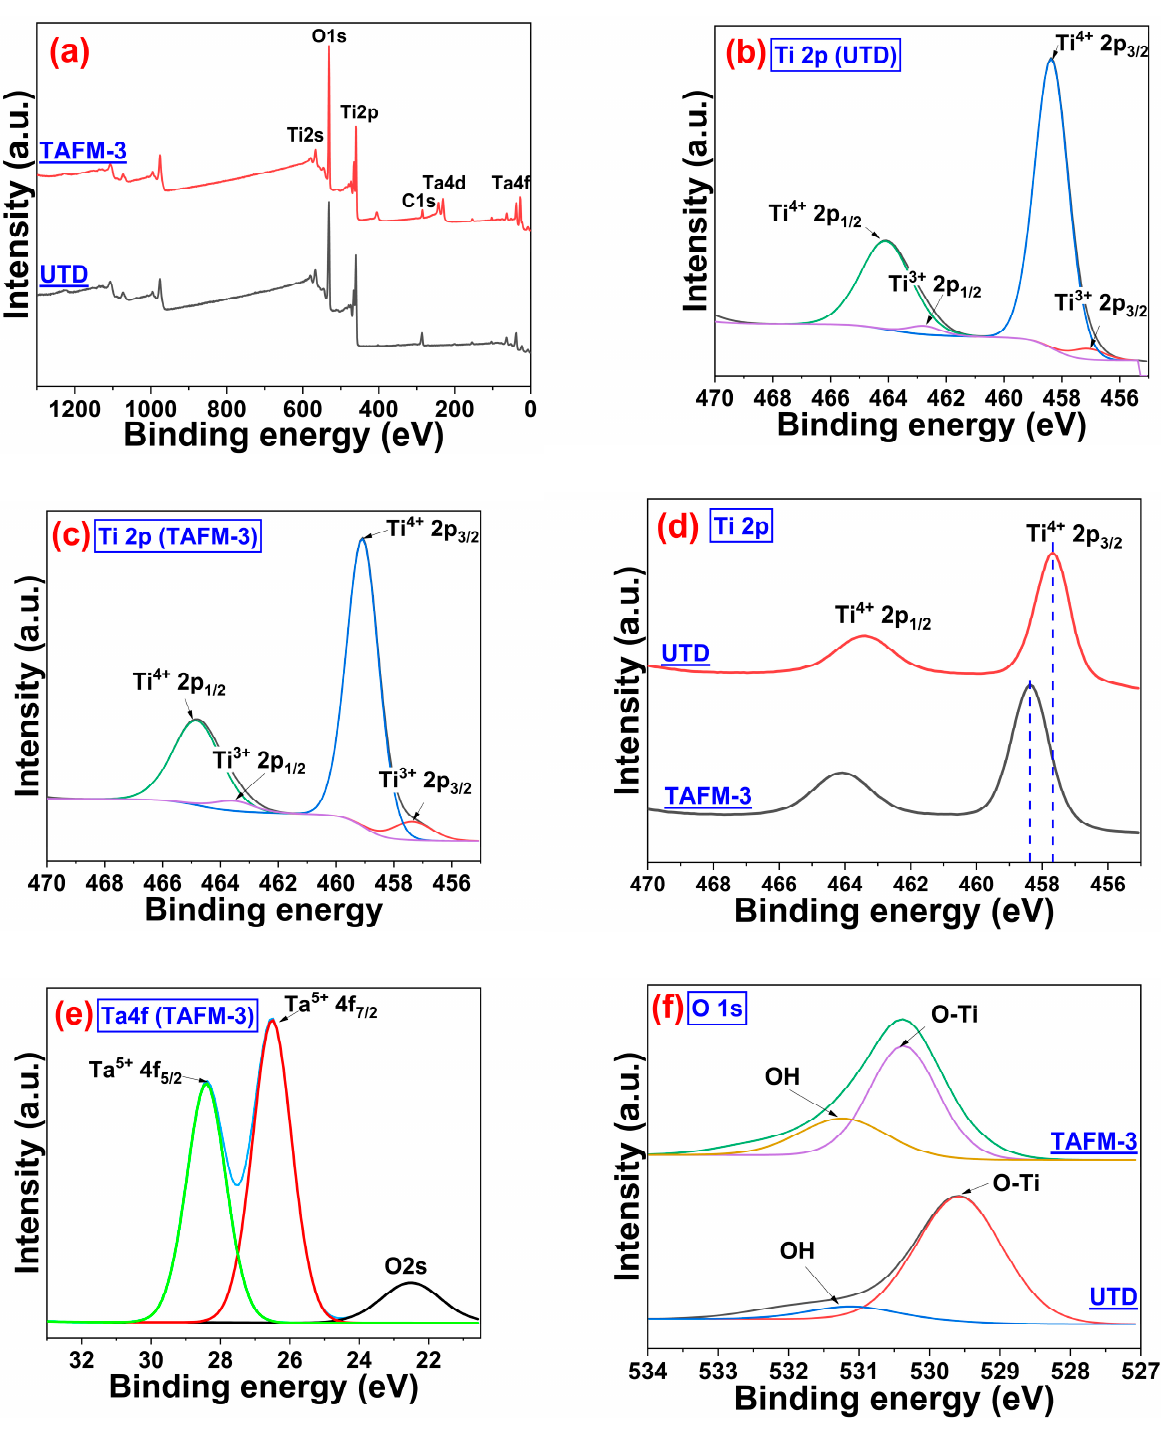
Figure 4. ( a ) XPS survey scan of UTD and TAFM-3, ( b ) Ti 2p scan of UTD, ( c ) Ti 2p scan of TAFM-3, ( d ) Ti 2p shift, ( e ) Ta4f scan of TAFM-3, and ( f ) O1s scan of UTD and TAFM-3.